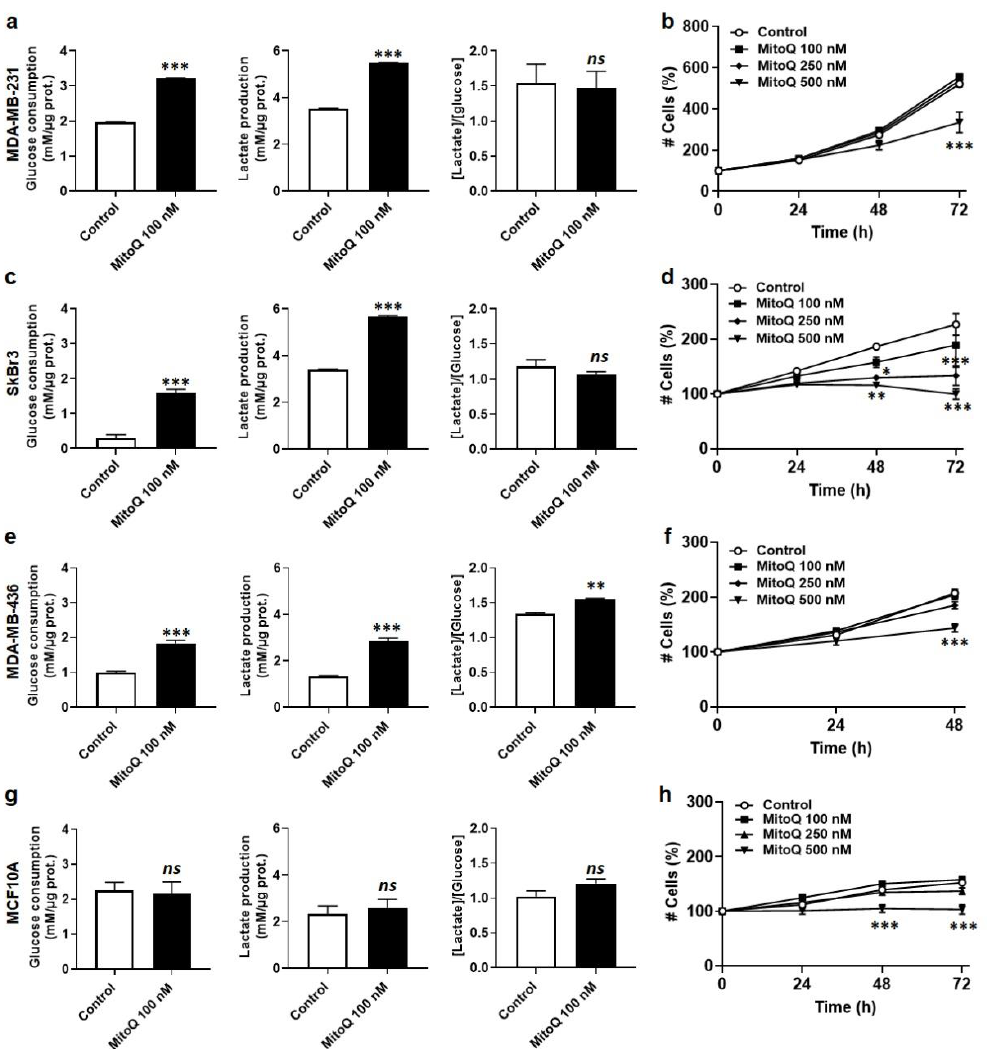
Figure 3. MitoQ increases glucose consumption and lactate release by human breast cancer cells, and is cytostatic at doses ≥ 250 nM. ( a ) MDA-MB-231 cells were treated ± MitoQ 100 nM for 48 h. Glucose consumption (left), lactate production (middle) and the lactate/glucose ratio (right) were then determined using enzymatic assays on a CMA600 analyzer ( n = 3 all). ( b ) Viable MDA-MB-231 cells were counted on a SpectraMax i3 spectrophotometer at the indicated time points after treatment with increasing doses of MitoQ ( n = 4). ( c ) Enzymatic measurements of glucose and lactate consumption as in a, but using SkBr3 cells ( n = 10). ( d ) SkBr3 cell viability was determined as in b ( n = 8). ( e ) Enzymatic measurements of glucose and lactate consumption as in a, but using MDA-MB-436 cells ( n = 10). ( f ) MDA-MB-436 cell viability was determined as in b ( n = 8). ( g ) Enzymatic measurements of glucose and lactate consumption as in a, but using MCF10A normal epithelial breast cells ( n = 4). ( h ) MCF10A cell viability was determined as in b ( n = 8). All data are shown as means ± SEM. * p < 0.05, ** p < 0.01, *** p < 0.001 compared to control; ns : p > 0.05 compared